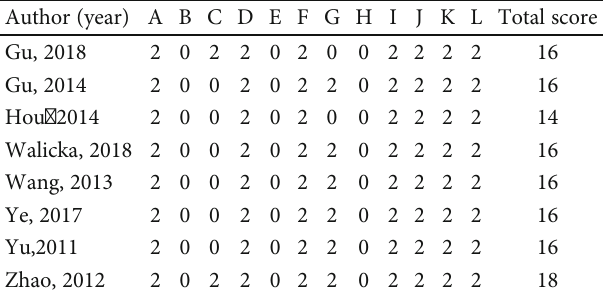
Table 3: Methodological quality of the NRCCTs.